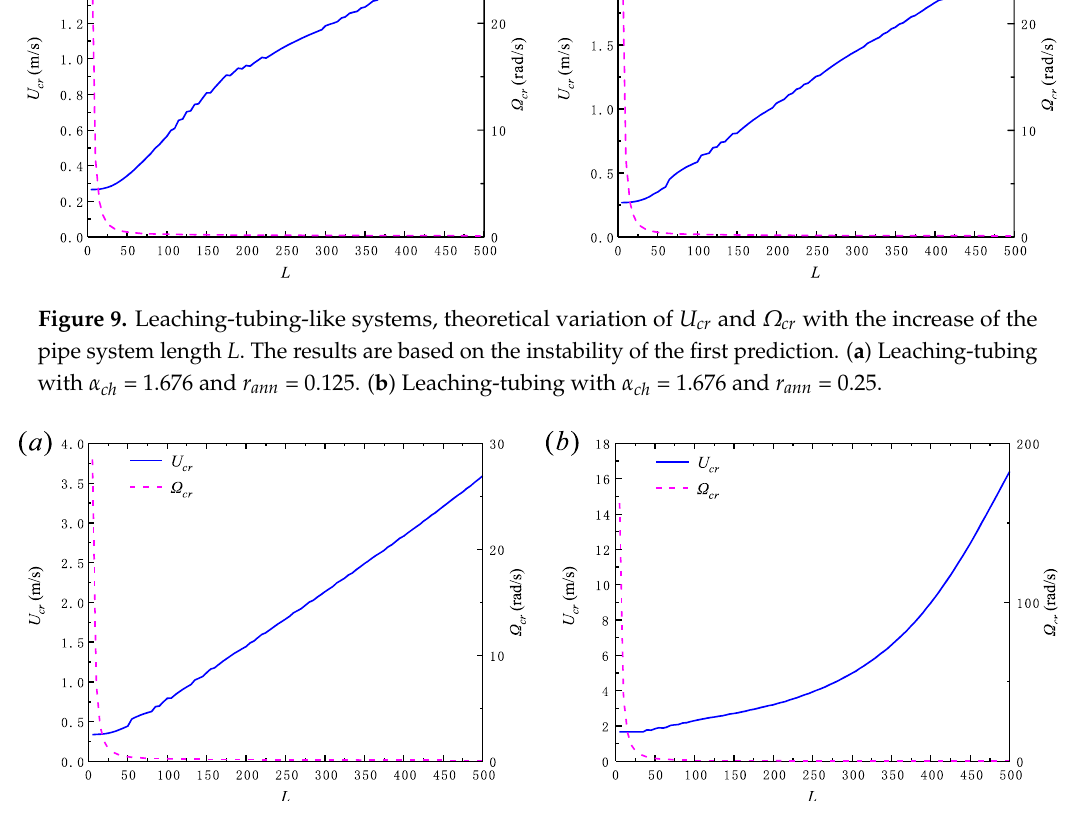
Figure 10. Leaching-tubing-like systems, theoretical variation of U cr and Ω cr with the increase of the pipe system length L . The results are based on the instability of the first prediction. ( a ) Leaching-tubing with α ch = 1.676 and r ann = 0.50. ( b ) Leaching-tubing with α ch = 1.676 and r ann =